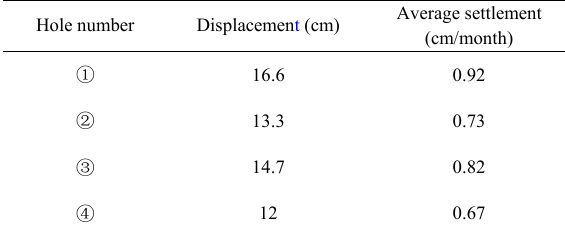
Table 2 Statistics of monitoring data.